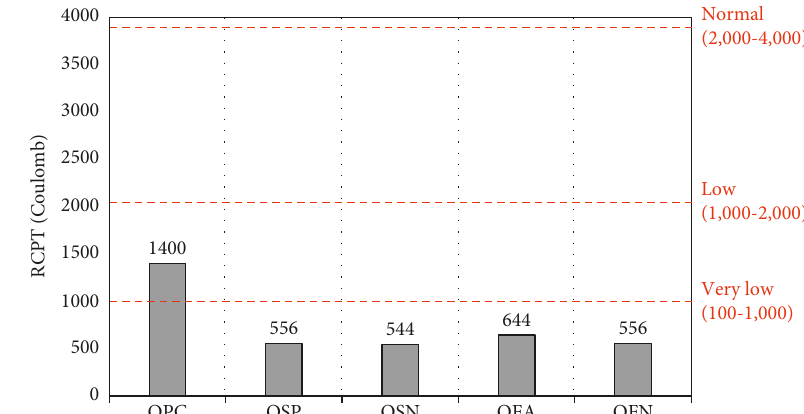
Figure 6: Resistance to chloride penetration.